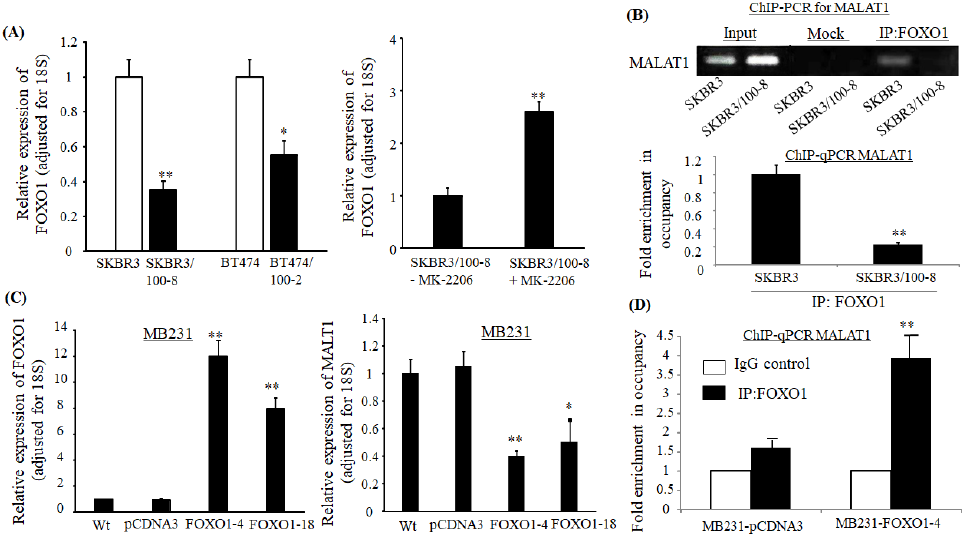
Figure 5. FOXO1 regulates the expression of MALAT1. ( A ). Total RNA extracted from SKBR3, SKBR / 100-8, BT474, and BT474 / 100-2 (left panel), and SKBR3 / 100-8 cells treated with MK-226 for 48 h (right panel). RT-qPCR was used to determine the expression of FOXO1, and the bar graphs indicate the level of FOXO1 relative to 18S. Each bar represents mean ± SEM from four independent experiments. A low level of FOXO1 was seen in trastuzumab-resistant cells, * p < 0.05 and ** p < 0.01, compared to SKBR3 or BT474, respectively. MK-2206 treatment of SKBR3 / 100-8 increased the FOXO1 level, ** p < 0.01, compared to SKBR3 / 100-8 without MK-226 treatment. An ANOVA test was used to determine significance. ( B ). FOXO1 binding to the promoter of MALAT1 in the indicated cells was determined by individual ChIP-PCR (top, n = 3) and ChIP-qPCR (bottom, n = 3) assays as described in the Method section. The image at the top shows the photo of a gel from a representative ChIP-PCR using MALAT1-specific primers for each condition. The bar graph in the bottom shows data from ChIP-qPCR of the specified samples. The bars in the graph indicate the fold enrichment (mean ± SEM) of FOXO1 binding to the promoter of MALAT1 in SKBR3 and SKBR3 / 100-8 cells compared to mock cells (immunoprecipitated with IgG) ** p < 0.01 compared to SKBR3 cells as determined by the ANOVA test. ( C ). Total RNA extracted from MB231 (wt), MB231 transfected with vector (pCDNA3), and MB231 stably transfected with full-length FOXO1 (FOXO1-4 and FOXO1-18) cells. RT-qPCR was used to determine the expression of FOXO1 and MALAT1. The bar graphs indicate levels of FOXO1 (left panel) and MALAT1 (right panel) relative to 18S. Each bar shows mean ± SEM from four repeated experiments. Overexpressing FOXO1 in MB231 cells reduced MALAT expression, * p < 0 . 05, and **p < 0.01 , compared to wt and pCDNA3 cells as determined by the ANOVA test. ( D ). Individual ChIP-qPCR ( n = 3) assays were conducted. The bar graph indicates fold enrichment of FOXO1 (mean ± SEM) binding to the promoter of MALAT1 in MB231-pCDNA3 and MB231-FOXO1-4 cells. Overexpression of FOXO1 increased its occupancy of MALAT1 promoter, * * p < 0.01 , compared to IgG control cells as determined by the ANOVA test.